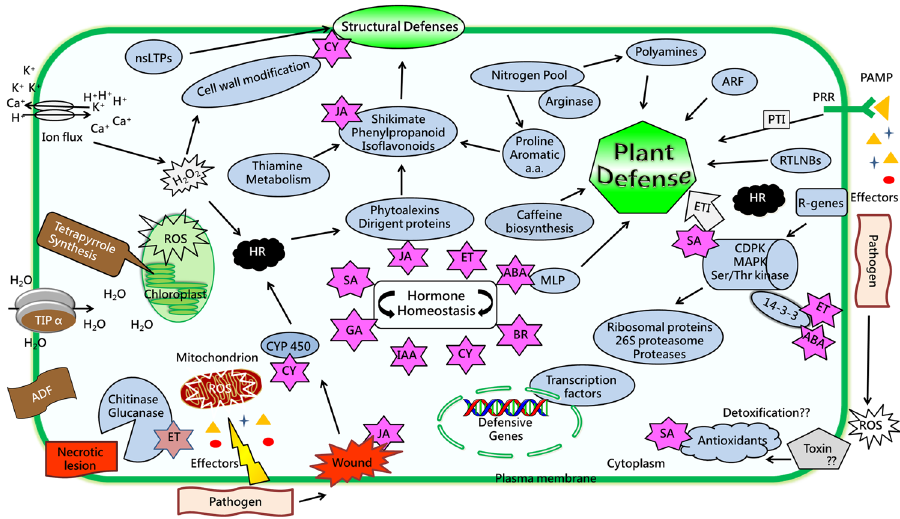
Figure 3. Schematic representation showing the interconnections of different biological processes induced in chickpea. Representation shows cell processes contributing to defense response in resistant cultivar (Blue and green color) with few processes that might render weakened response in susceptible cultivar (brown